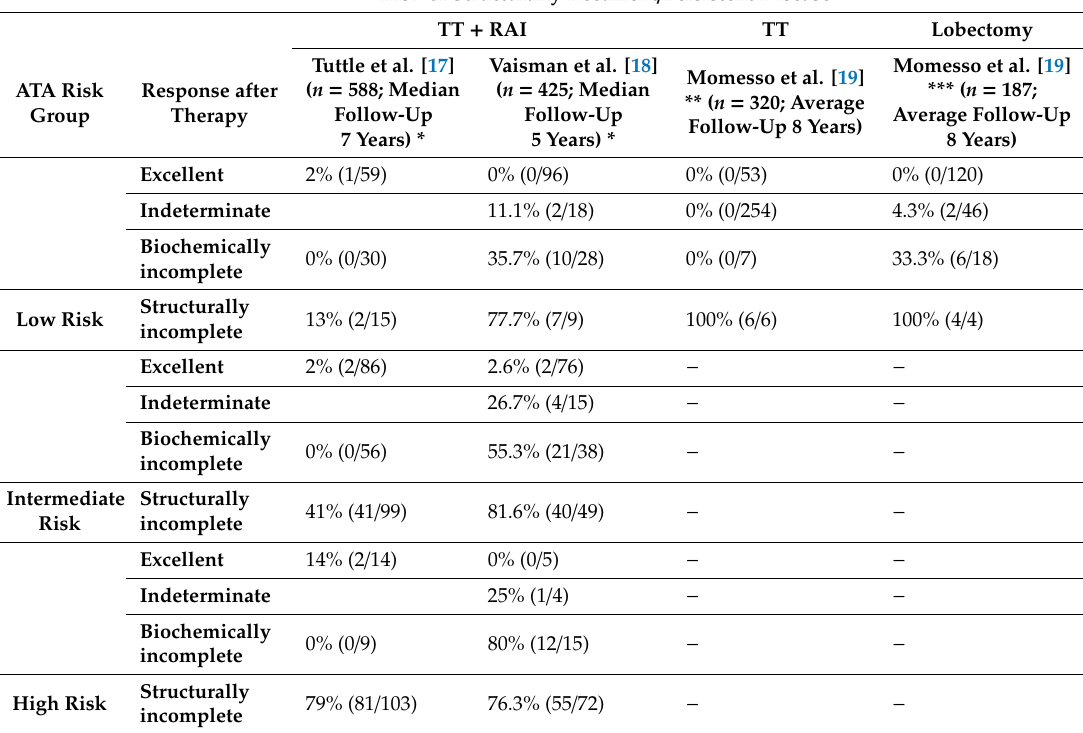
Table 2. Risk of structurally recurrent / persistent disease according to initial ATA risk classification and ongoing risk